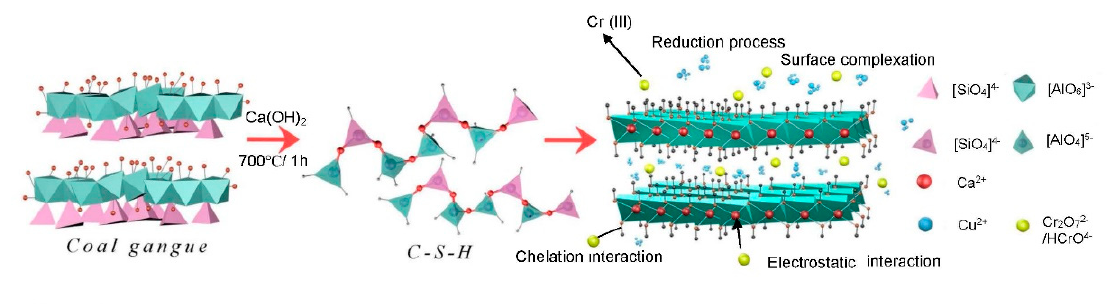
Figure 5. Synthesis of C-S-H and adsorption mechanism.